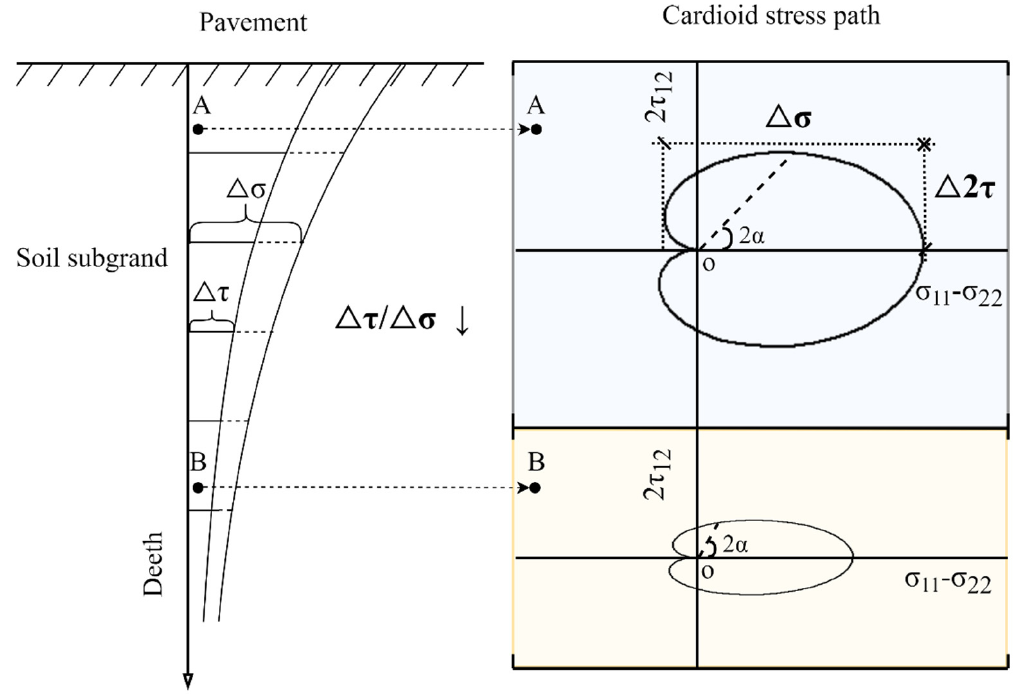
Figure 2. Schematic diagram of degradation of soil stress with depth.